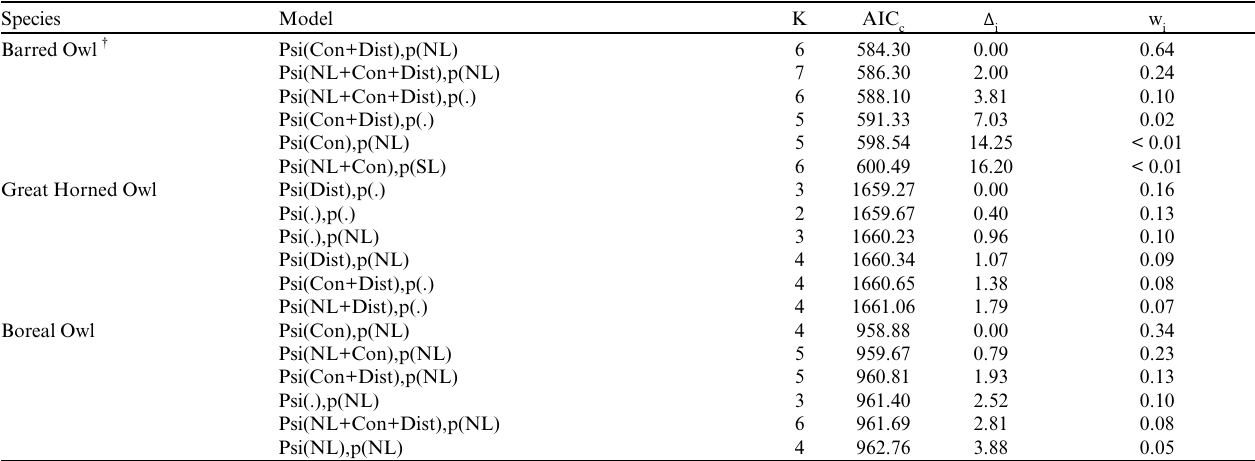
Table 3 . Comparison of occupancy models for owls at the station level (n = 353 stations). Occupancy (psi) and detection probability (p) are modeled with the relative noise level (NL) measured in Raven Pro as a factor. Percent coniferous forest (Con) and proportion of the area disturbed by humans (Dist) were included as factors to account for differences in forest composition and disturbance. The number of parameters is represented by K. Models were evaluated based on differences between AIC the first six models with the lowest Δ are reported here, Δ is the difference between the observed model (i) and the best model as determined i i by the lowest AIC . c